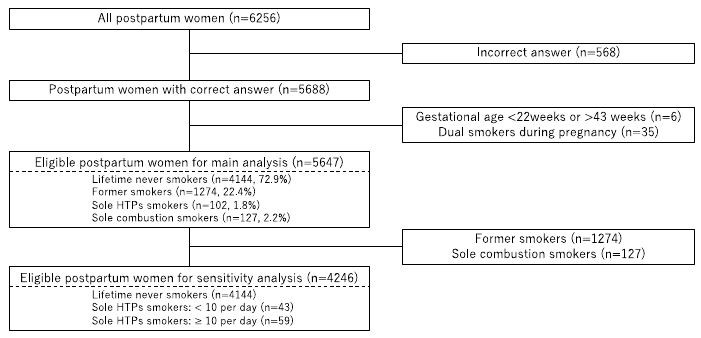
Figure 1. Flowchart of post-delivery women recruitment.